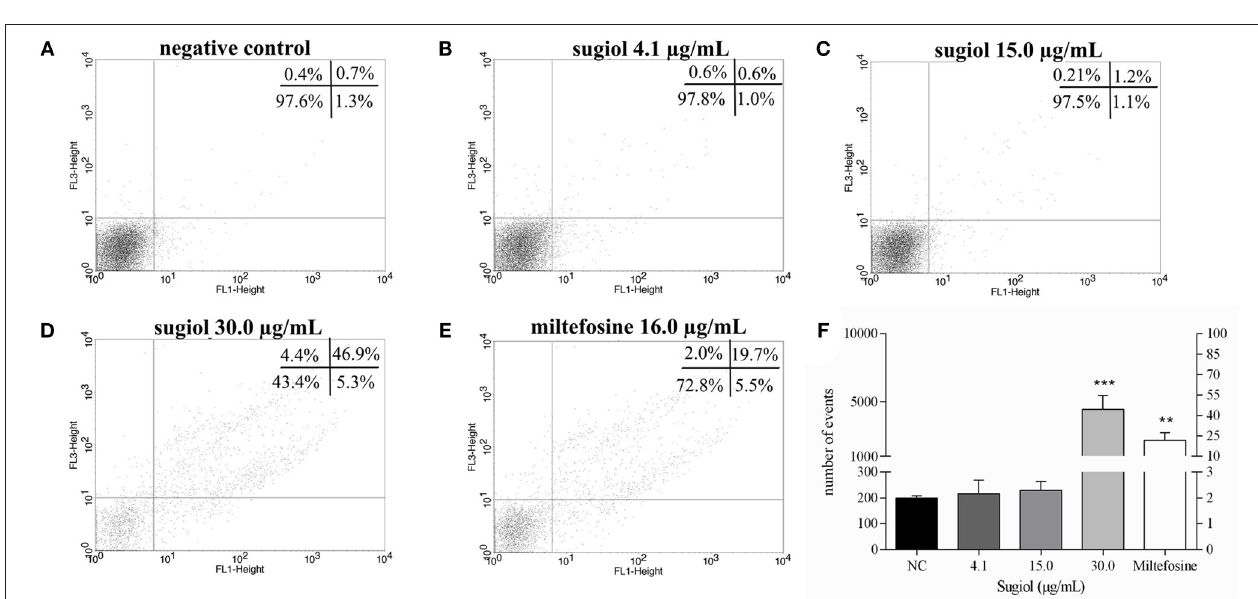
FIGURE 4 | Exposure of phosphatidylserine and plasma membrane integrity detected on BD FACScalibur flow cytometer using Annexin V-FITC and PI. (A) Non-treated promastigotes and (B–D) treated with different concentrations of sugiol. (E) Miltefosine at 16.0 µ g/mL was used as positive control. In each experimental replicate, 10,000 events were analyzed. Representative dot plot of three independent experiments was shown. The mean ± SD of the events and the corresponding percentage from Annexin V + represented in upper (Annexin-V + PI + ) and lower (Annexin-V + PI-) right quadrants in the dot plot is showed in the letter (F) . ** p < 0.01 and *** p < 0.001, significant difference in comparison to the negative control (NC) group.